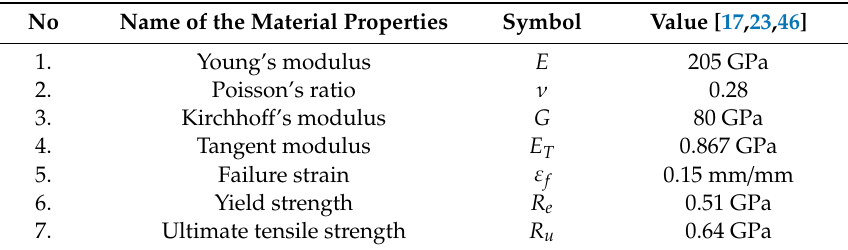
Table 1. Mechanical properties of material being cut—cold-rolled streel C75S. No Name of the Material